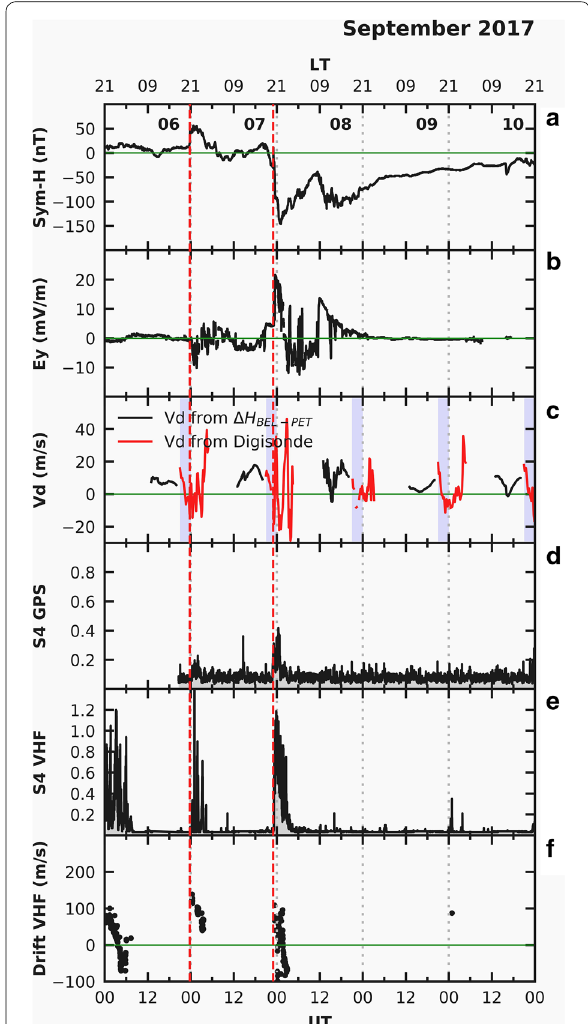
Fig. 3 Magnetic index Sym-H ( a ), eastward interplanetary electric field E y ( b ), ionospheric vertical plasma drift V d ( c ), GPS S4 index ( d ), VHF S4 index ( e ) and the VHF zonal drift ( f ) for the days 06 to 10. The light blue shaded area at c represents the prereversal period of 21:00–24:00 UT (18:00–21:00 LT), and the vertical dashed red lines represent the 2